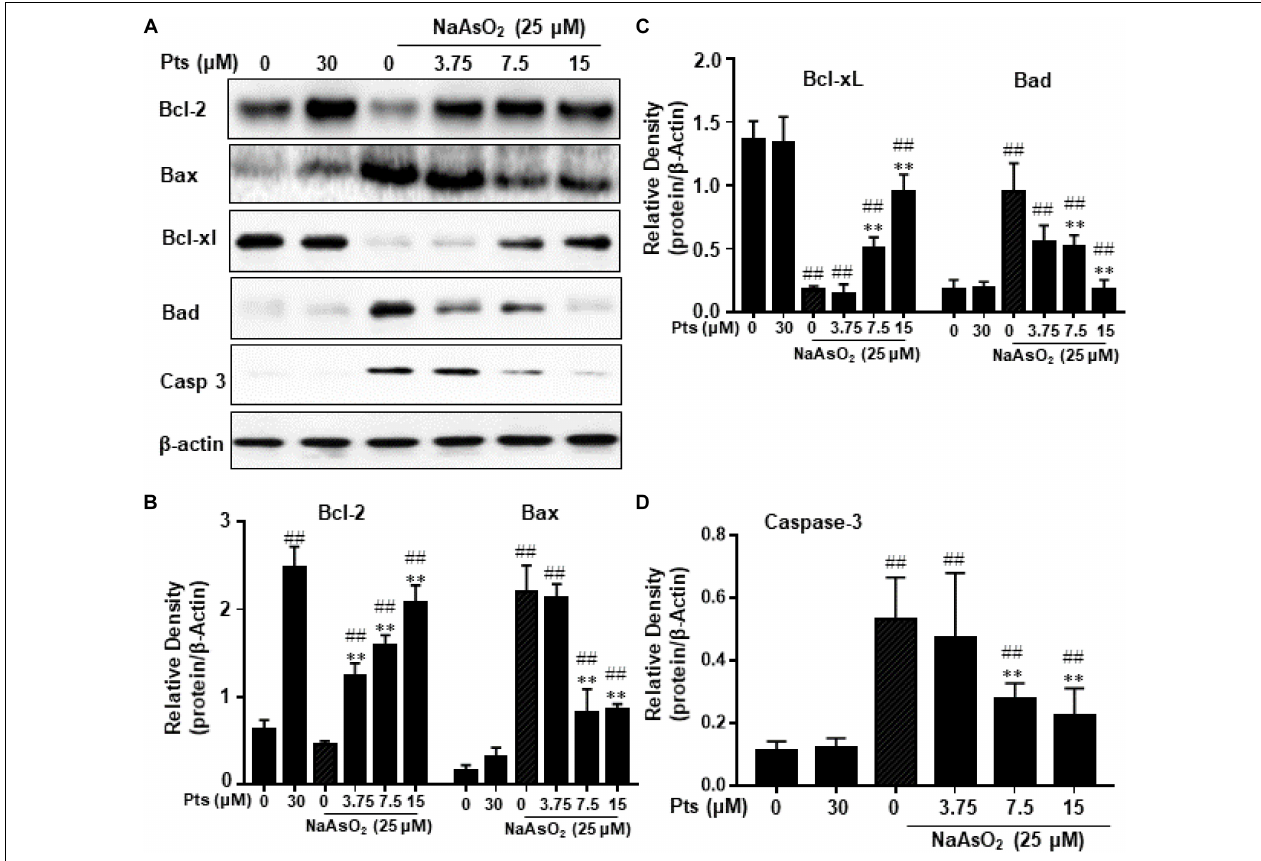
FIGURE 5 | Effects of Pts on apoptosis-related protein expression in arsenic-treated HaCaT cells. The HaCaT cells were exposed to 25 µ M of NaAsO 2 for 24 h with or without Pts (3.75, 7.5, and 15 µ M) pretreatment. (A) Bcl-2, Bax, Bcl-xl, Bad and Casp 3 protein levels from total cell lysates were detected by western blot analysis, and the band densities were quantified in panels (B–D) . The results are expressed as the means ± S.E.M. of three independent experiments. ## P ≤ 0.01 versus the control group, ∗∗ P ≤ 0.01 versus the NaAsO 2